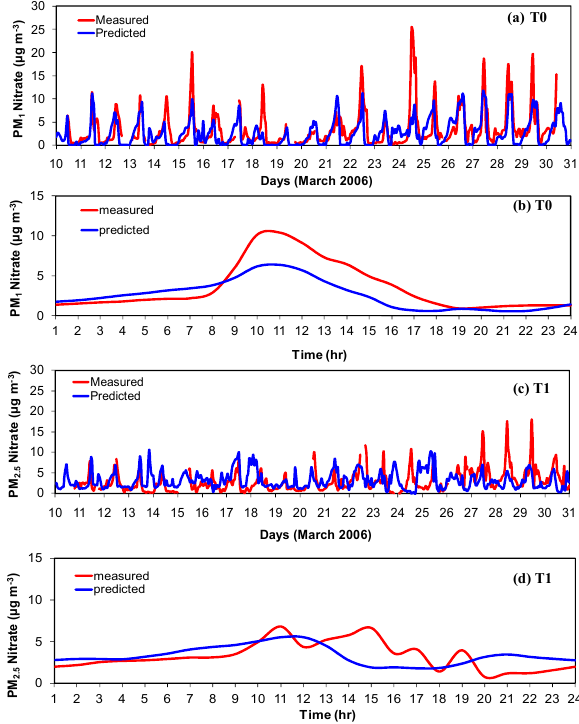
Figure 6: Comparison of model hourly and diurnal predictions against measurements for PM 1 nitrate taken at T0 (a, b) and PM 2.5 nitrate taken at T1 (c, d) during the MILAGRO campaign.